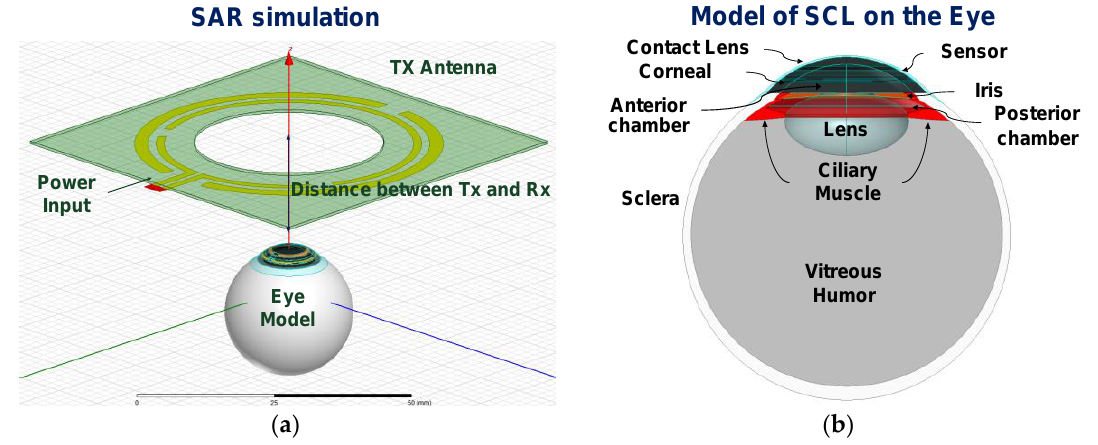
Figure 3. ( a ) Configuration of the simulation; ( b ) Eye model for specific absorption rate (SAR) simulation.